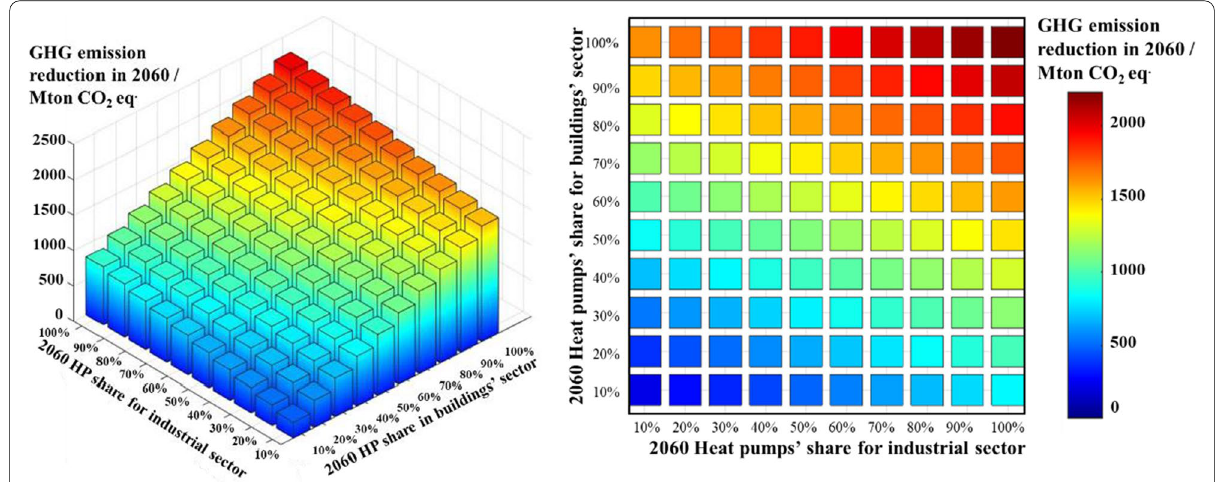
Fig. 10 Decarbonization potential of heat pump in 2060 with increasing share for industrial and buildings’